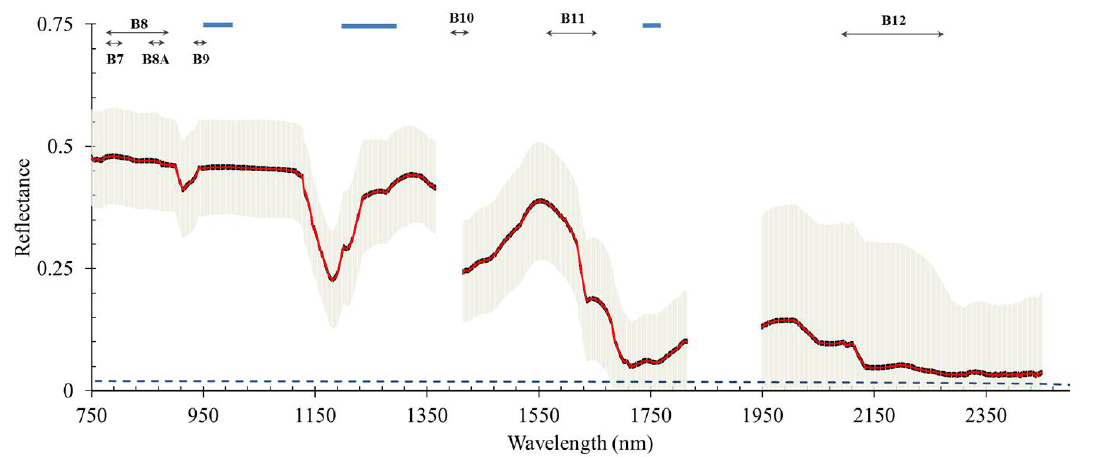
Figure 2. Near-infrared short-wave infrared (NIR-SWIR) reflectance spectrum (%), plastic absorption feature locations and satellite detection windows. Thick solid red line is median reflectance spectrum and shadowed area is the standard deviation of all plastics measured (data adapted from [53]). Thick horizontal bars highlight the regions of the spectrum with major absorption features (data adapted from [50]). Double arrow end lines show the maximum width of the spectral response function and the band names of the Sentinel 2B Multi Spectral Imager (MSI). Dashed line is typical oceanic seawater reflectance shown for comparison (data corresponding to OPENOCEAN-SW2 spectra adapted from